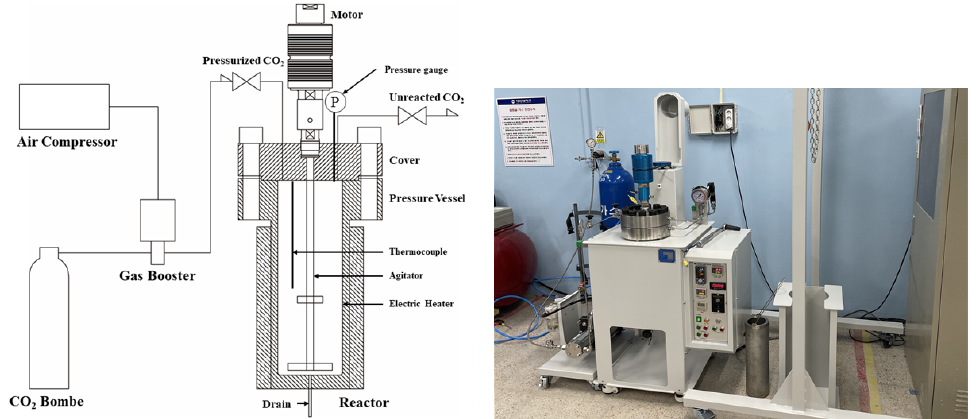
Figure 3. Schematic and photograph of the supercritical CO 2 reactor.